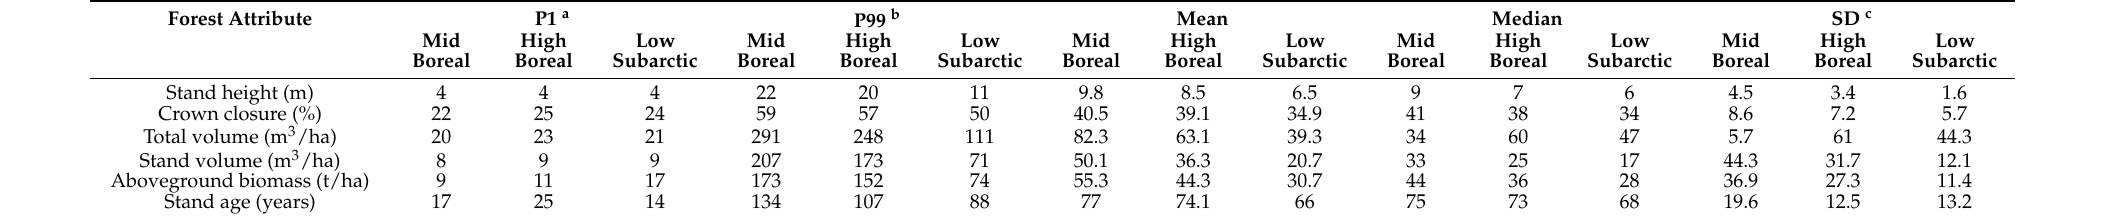
Table 9. Descriptive statistics for each of the forest attributes in each Level II ecoregion within the study